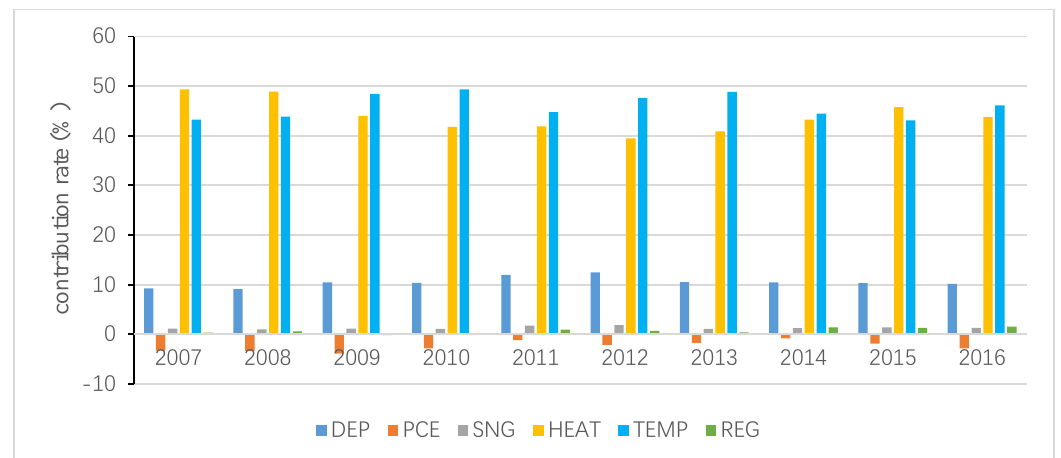
Figure 6. Decomposition result of URECP by GE0.